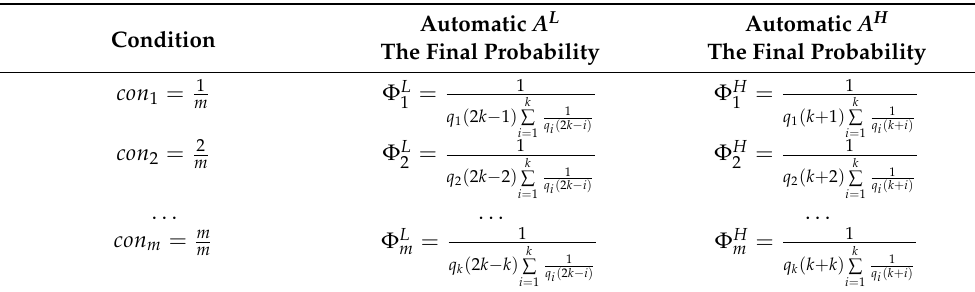
Table 1. Analytical expressions for final probabilities Φ L = (cid:8) Φ H (cid:9) , Φ H , . . . , Φ H m 2 1